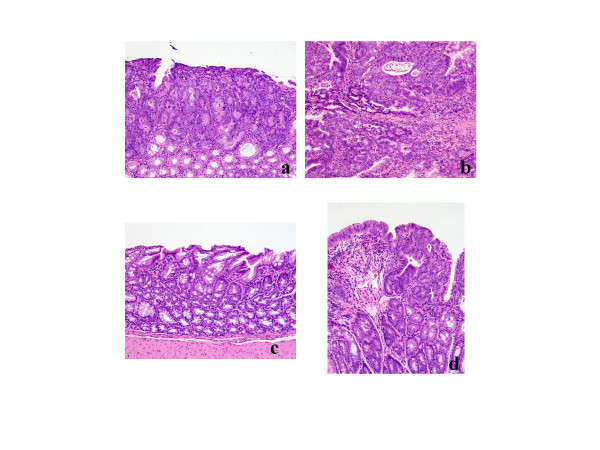
Histopathology of colonic lesions in mice of group 1. (a) adenoma, (b) adenocarcinoma, (c) mild dysplasia, and (d) severe dysplasia. Hematoxylin and eosin stain. Original magnifications, × 10.